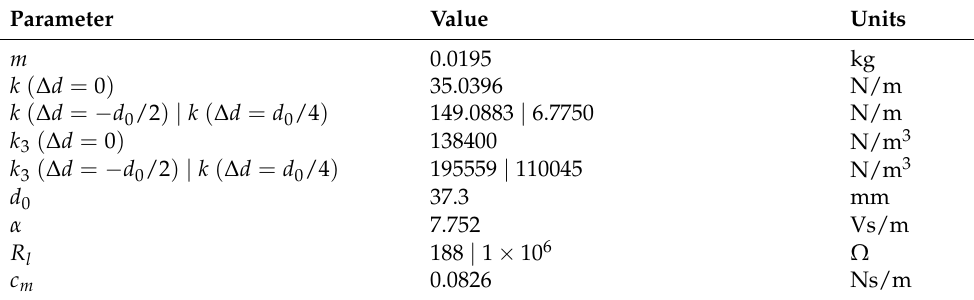
Table 1. Constant